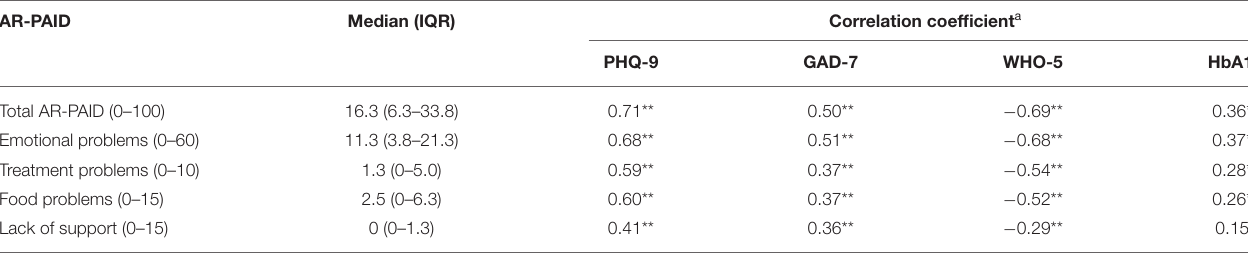
TABLE 4 | Correlations of the AR-PAID and its subscales with other measures of effect and HbA1c ( N = 200).